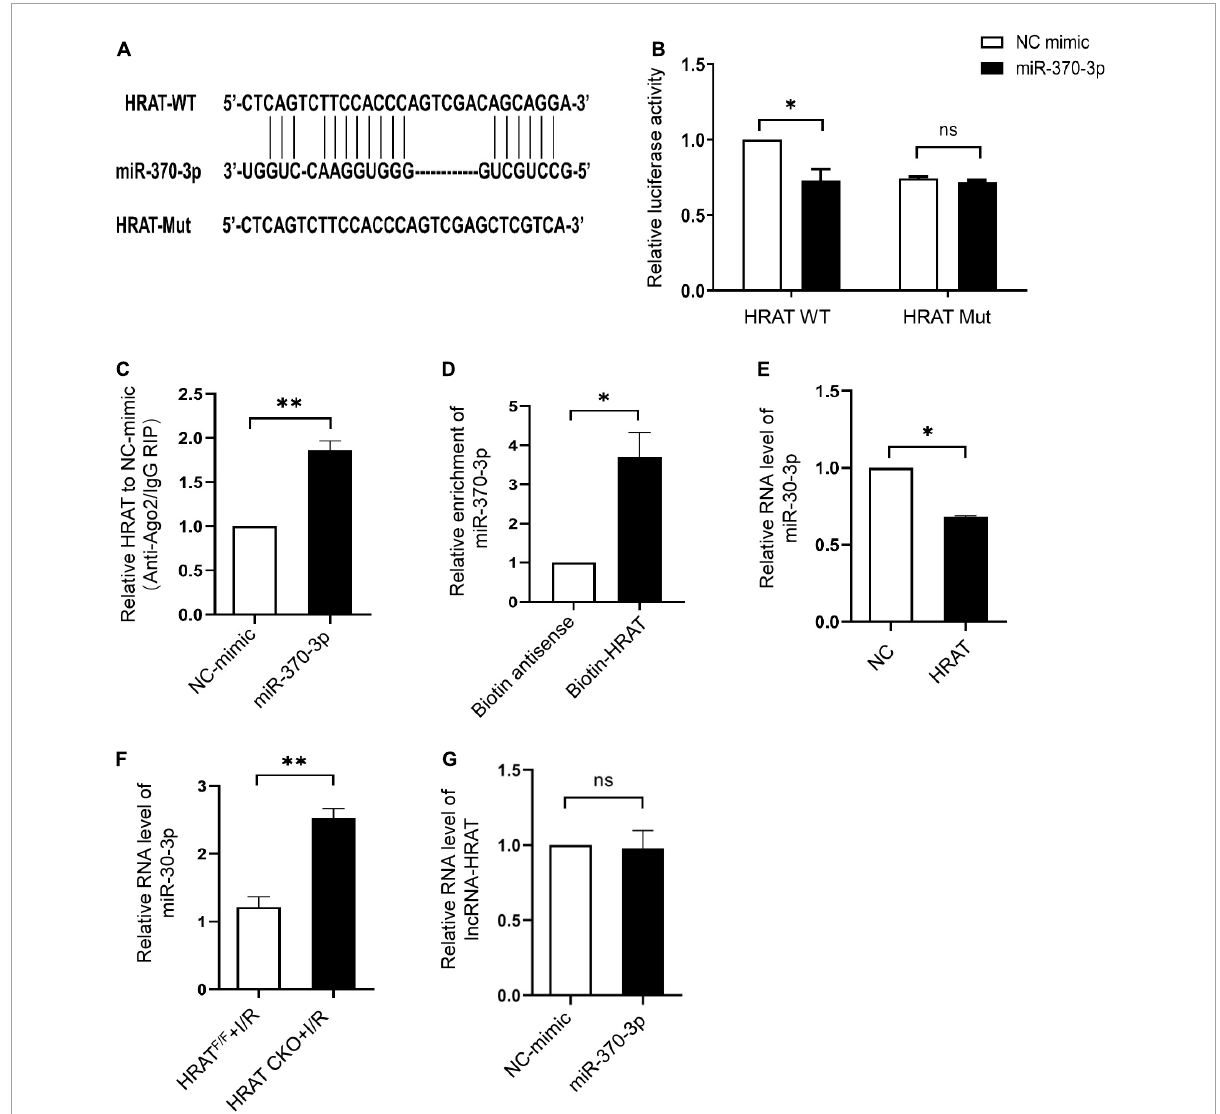
FIGURE5 LncRNA-HRAT targets on miR-370-3p directly. (A) Predicted binding site between lncRNA-HRAT and miR-370-3p. (B) The relative activity of luciferase in the lncRNA-HRAT wild-type/mutant reporter in HEK-293T cells, with or without miR-370-3p mimics was analyzed through dual luciferase reporter assay ( n = 3). (C) The enrichment of lncRNA-HRAT on Ago2 relative to IgG in H9c2 cells with or without miR-370-3p mimics was determined via RIP assay ( n = 3). (D) The binding of lncRNA-HRAT and miR-370-3p in H9c2 cells with biotin-antisense or biotin-HRAT probe treatment was tested through pull-down assay ( n = 3). (E) The analysis of miR-370-3p expression in H9c2 cells infected with lncRNA-HRAT or control lentivirus was conducted through qRT-PCR ( n = 3). (F) The expression of miR-370-3p in the hearts from HRAT F / F and HRAT CKO mice subjected to I/R (45’/3 hr) was detected by qRT-PCR ( n = 5). (G) LncRNA-HRAT expression in H9c2 cells with or without miR-370-3p mimics was analyzed through qRT-PCR ( n = 3). All the data are described as the mean ± SD. * P < 0.05, ns = not